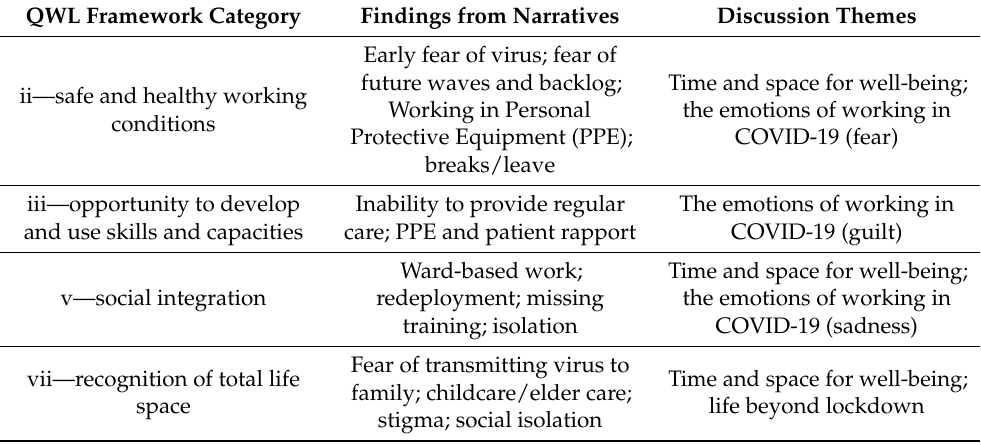
Table 2. Key elements of the Quality of Life (QWL) framework and alignment with study findings and experiences during